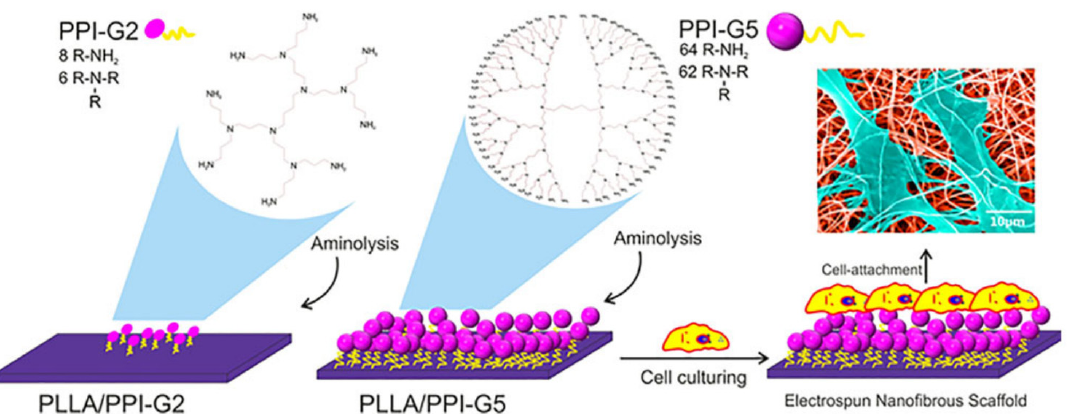
Figure 32. Incorporation of the second (G2) and fifth generation (G5) of Poly (propylene imine) (PPI) dendrimers onto the surface of PLLA scaffold via aminolysis reaction and the cultured fibroblast cells on the surface of electrospun PLLA/PPI-G5 scaffold. Reproduced with permission from [279] Copyright: Taylor & Francis.